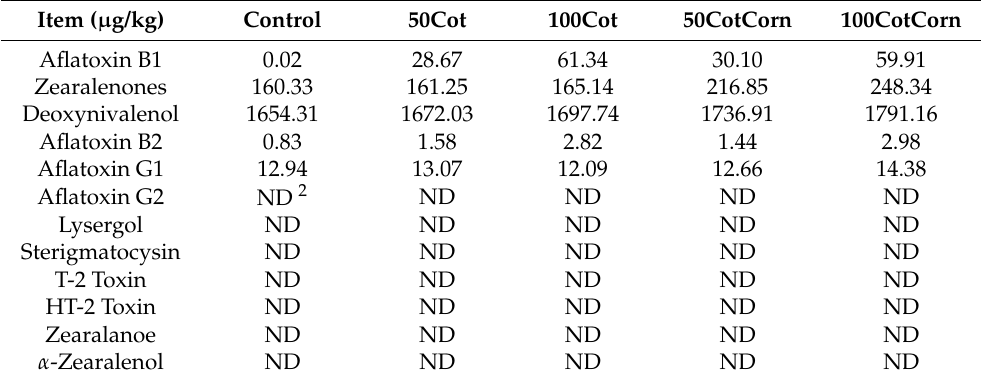
Table 3. The concentrations of major mycotoxins ( µ g/kg dry matter) 1 in the experimental diets for dairy cows. Item ( µ